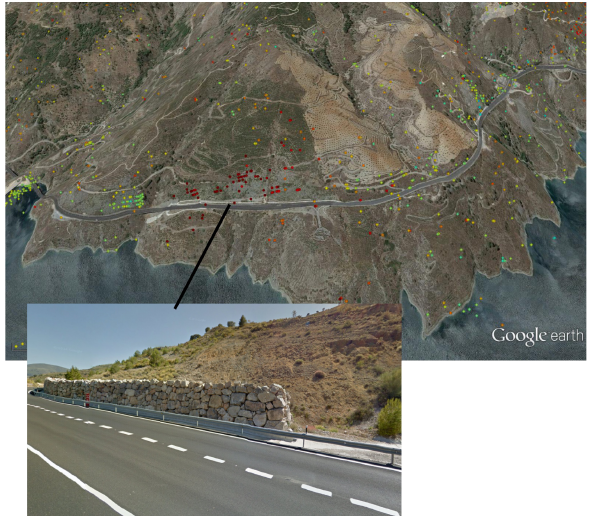
Figure 5. Landslide on the hillside in the Rules reservoir, Spain as detected by PS InSAR processing of Envisat (2002-2009).